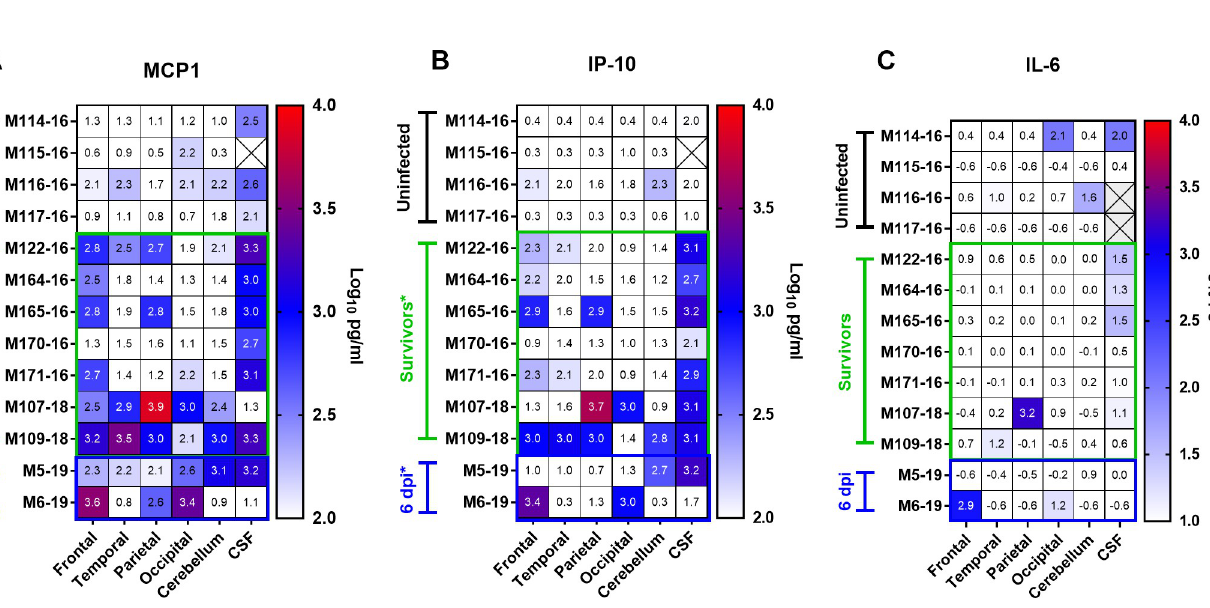
PLOS Pathogens| https://doi.org/10.1371/journal.ppat.1009946 June 13,